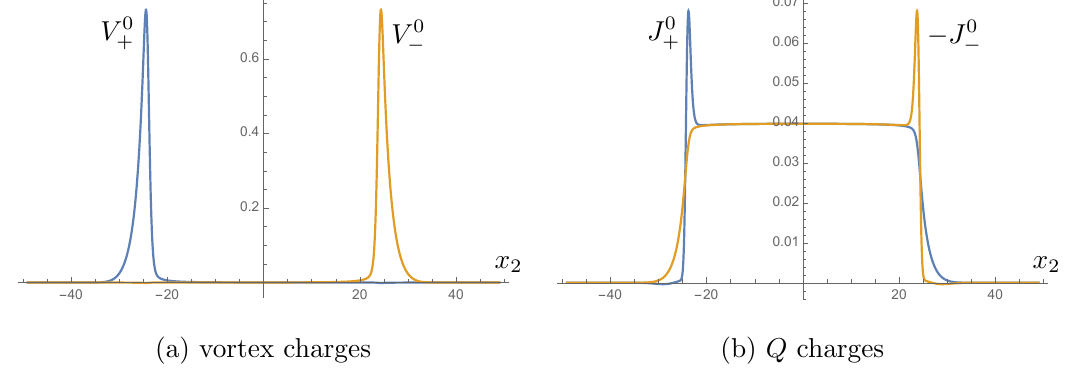
Figure 7 . Vortex and Noether charge densities with d = 1 = 10, ~ d = 50, m = (cid:25) , (cid:24) = 1, ( !; k ) = (1 ;